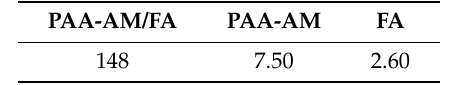
Table 6. The adsorption capacity for Rhodamine B by different superabsorbent composite (mg. g − 1 ). PAA-AM/FA PAA-AM